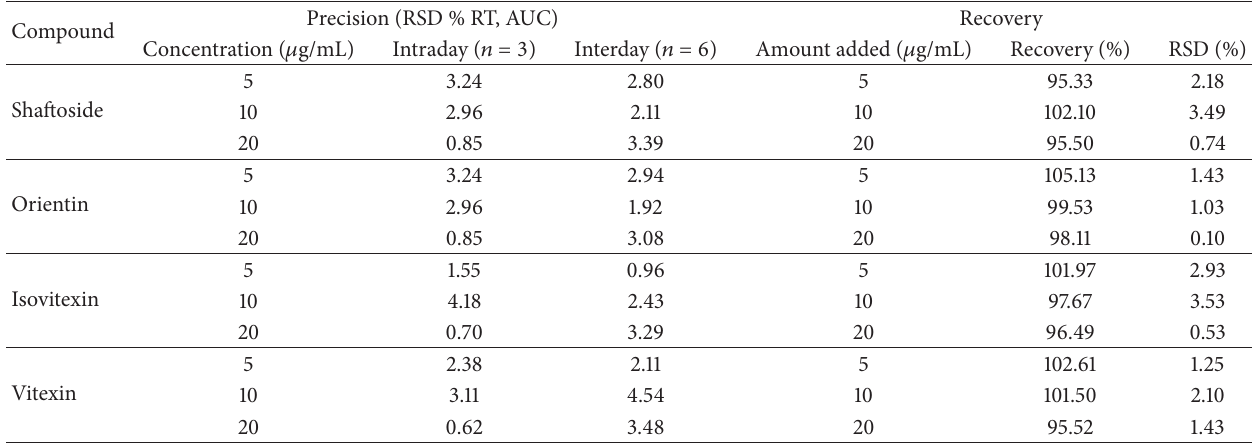
Table 2: Intra- and interday precision, recovery, and accuracy data.